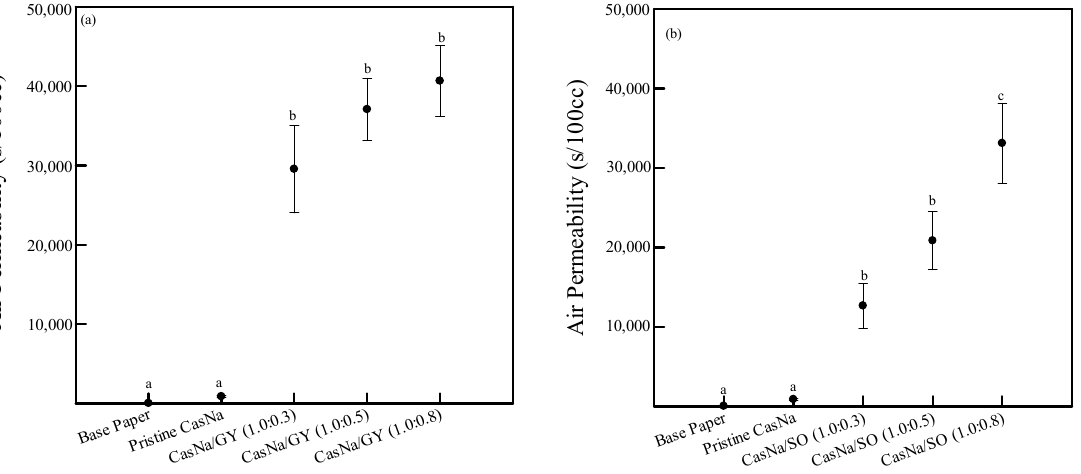
Figure 5. Air permeability of ( a ) CasNa/GY–coated papers and ( b ) CasNa/SO–coated papers. Lowercase letters (a–c) indicate statistically significant differences ( p < 0.05).